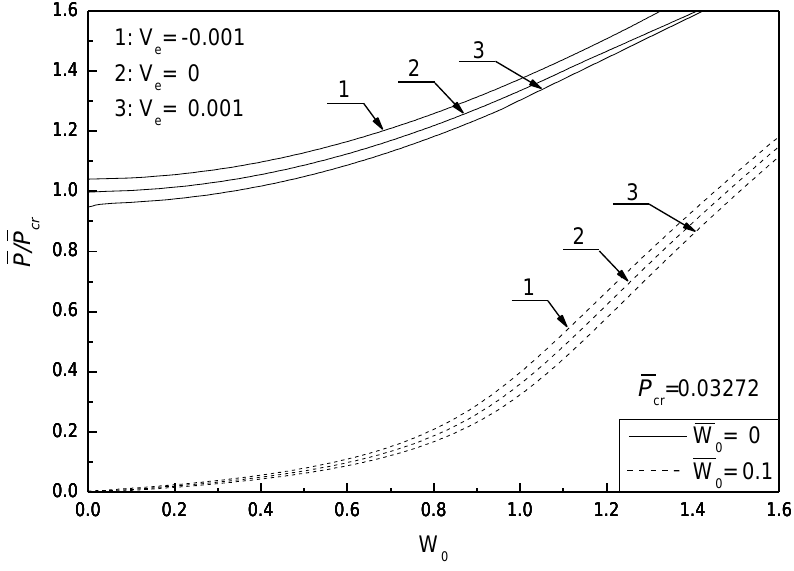
Figure 5. Comparisons of postbuckling response curves for initially flat and deflected piezoelectric plate without damage under different electrical loads.